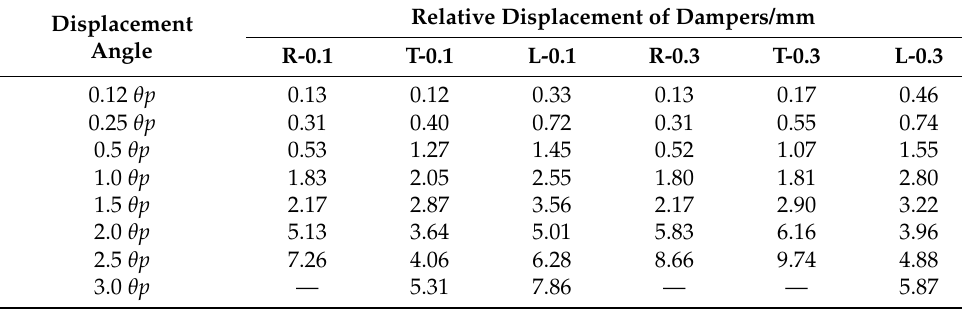
Table 8. Relative displacement of damper DZ.